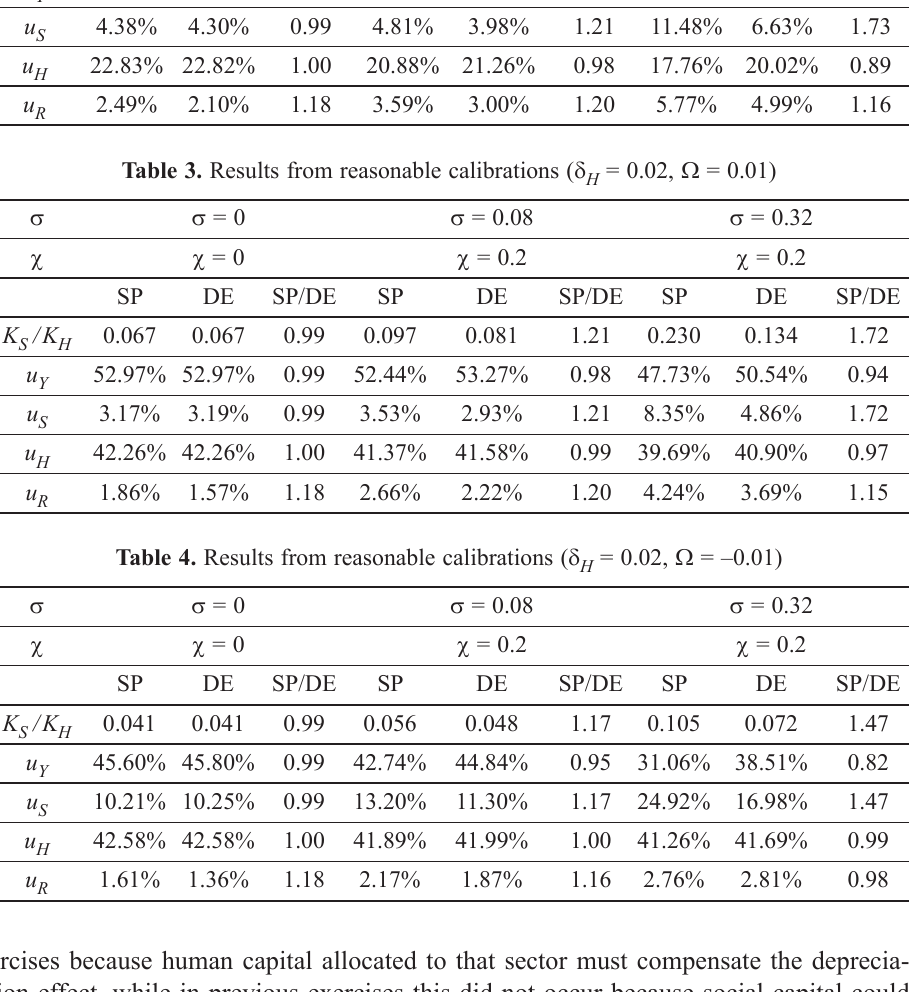
Table 3. Results from reasonable calibrations ( δ